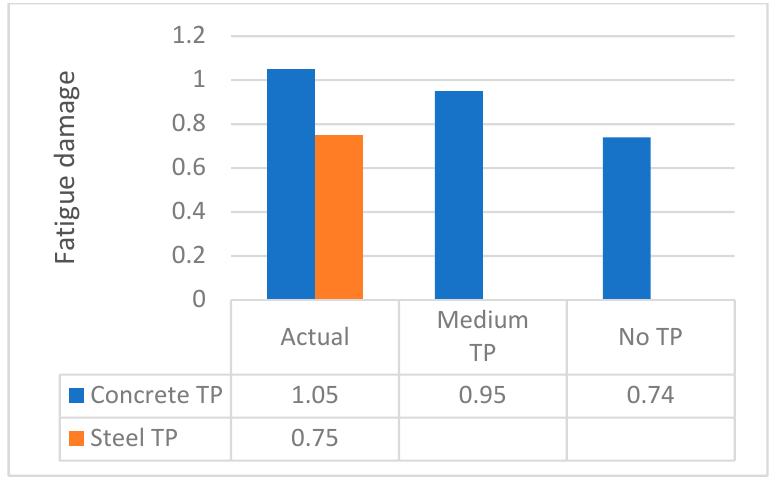
Figure 17. Effect of transition piece on the fatigue damage.